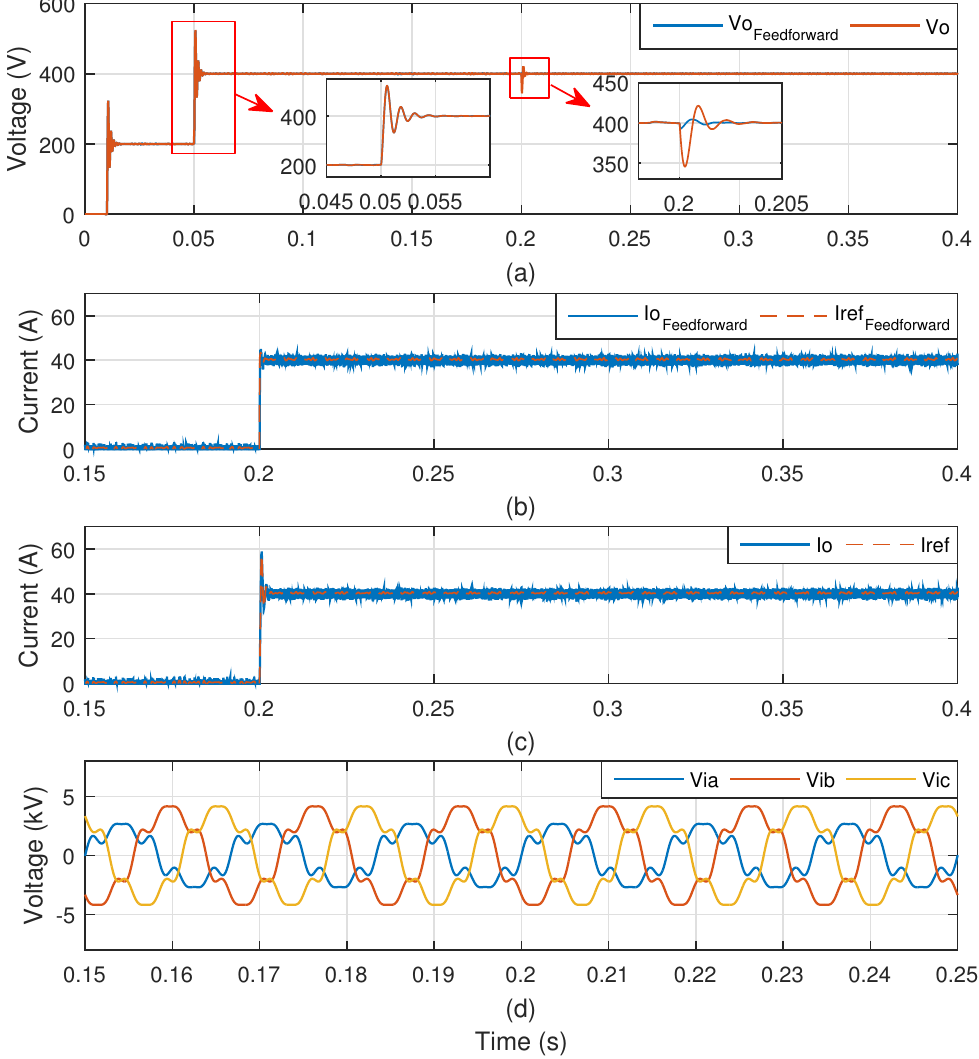
Figure 16. AC-DC 3 × 2 DMC operation with PI 4 ( s ) . ( a ) Output voltage with and without feedforward, ( b ) output current with feedforward, ( c ) output current without feedforward, and ( d ) distorted and unbalanced input